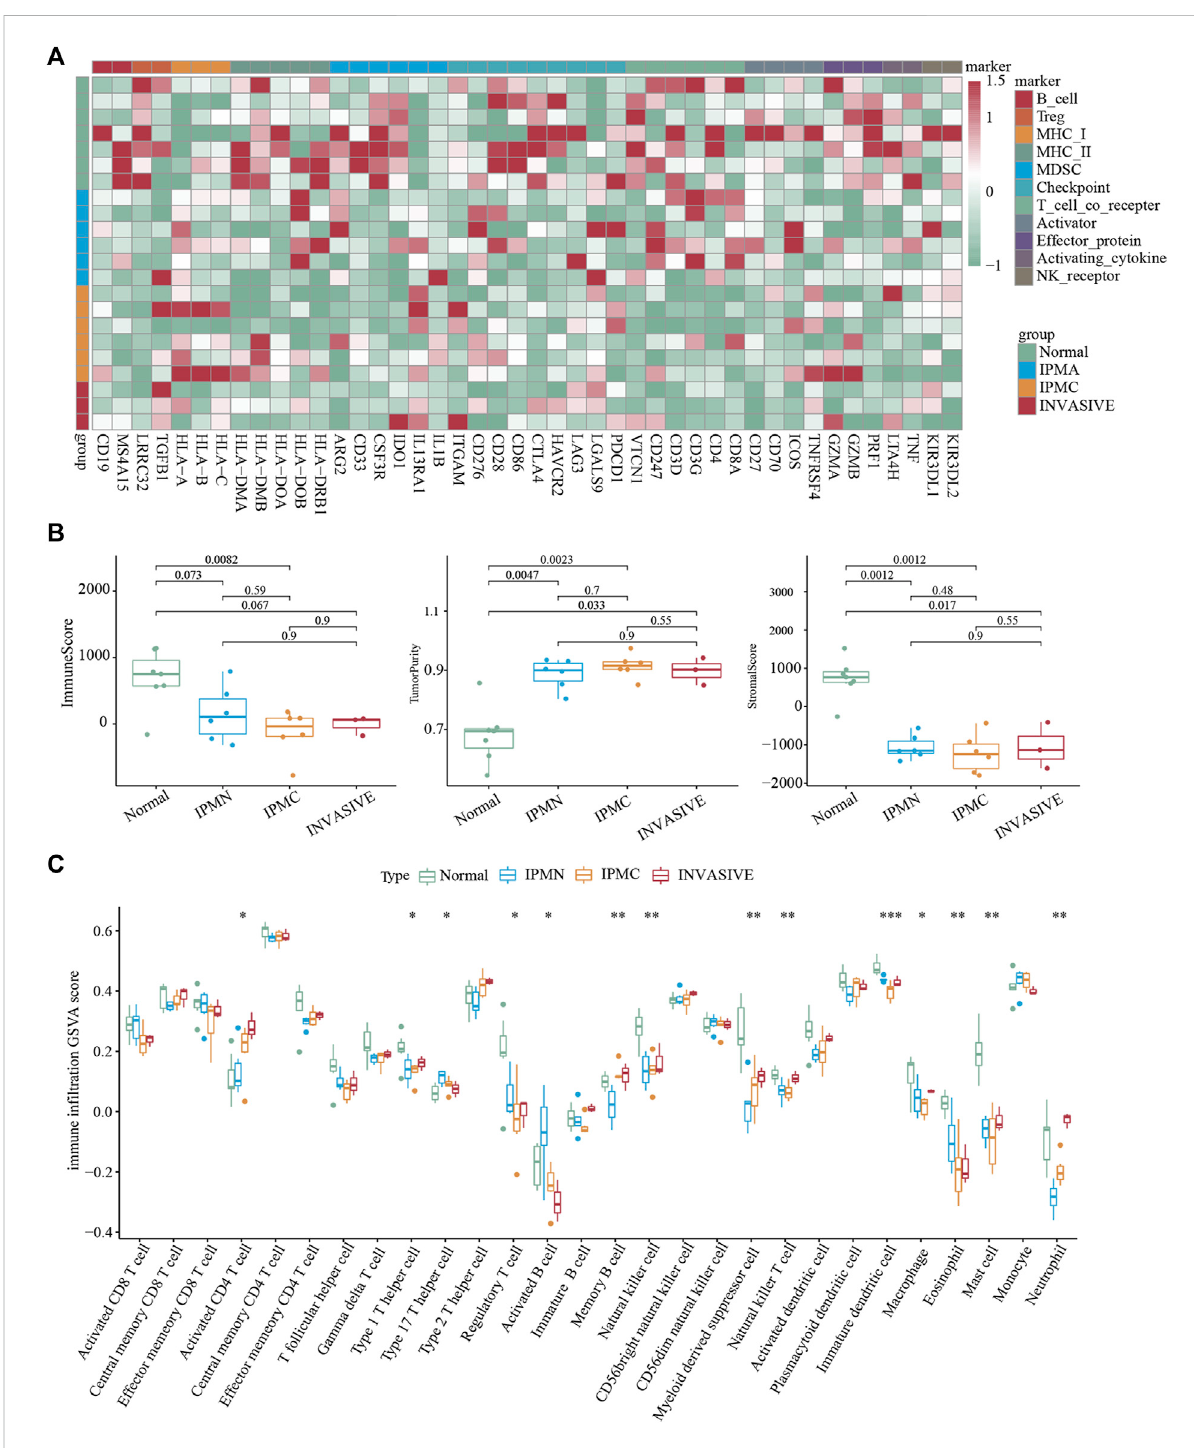
FIGURE 3 Immune microenvironment evaluation of lesions. (A) Unsupervised hierarchical clustering of Normal, IPMA, IPMC, and invasive samples using 46 immune cell markers. (B) Evaluation of Estimate, Immune, and Stromal Score. (C) The ssGSEA-inferred absolute in fi ltration of 28 immune cell types.* p < 0.05; ** p < 0.01; *** p < 0.001. Boxplots show mean ±